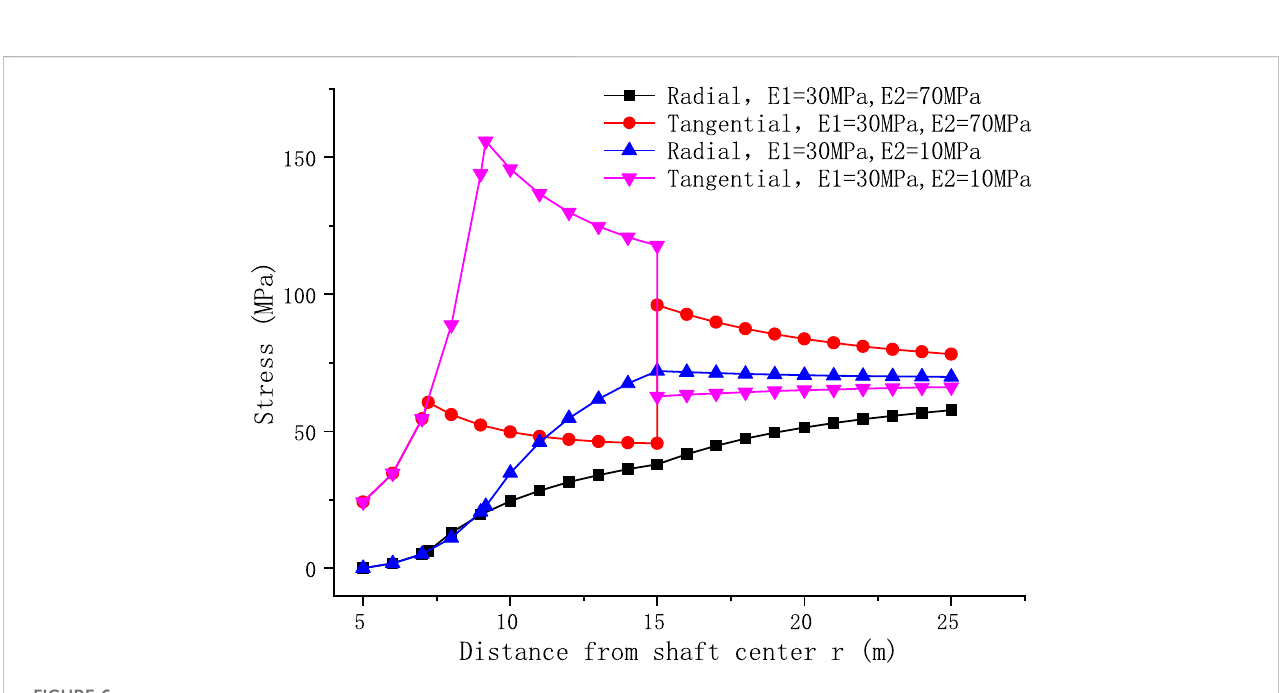
FIGURE 6 Effect of elastic modulus of original surrounding rock on stress fi